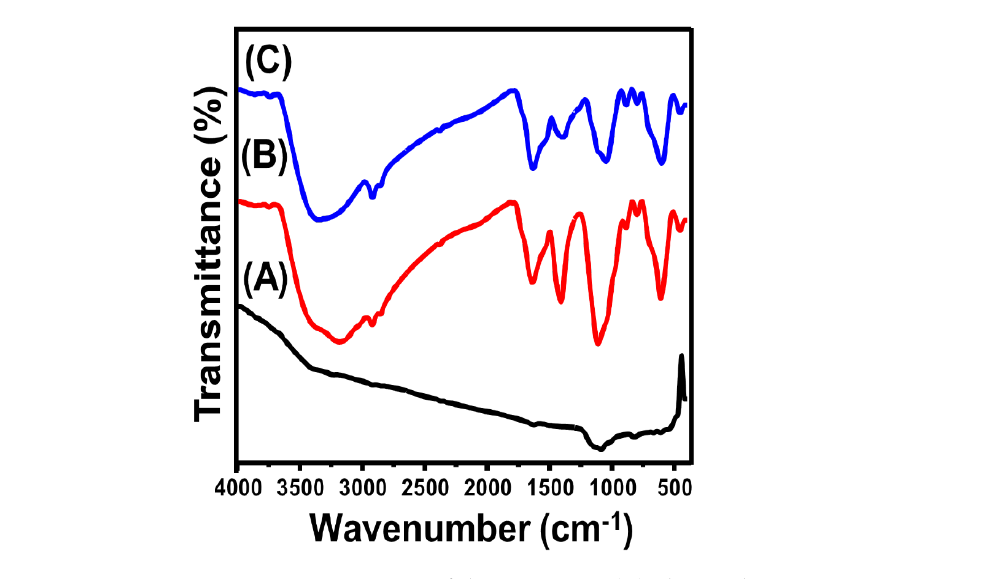
Figure 3. FT – IR spectra of the raw pyrite ( A ), the synthetic green magnetite nano particles over the surface of carbonized coffee (MG/CFC) ( B ), and spent MG/CFC after the adsorption of C.R molecules ( C ).